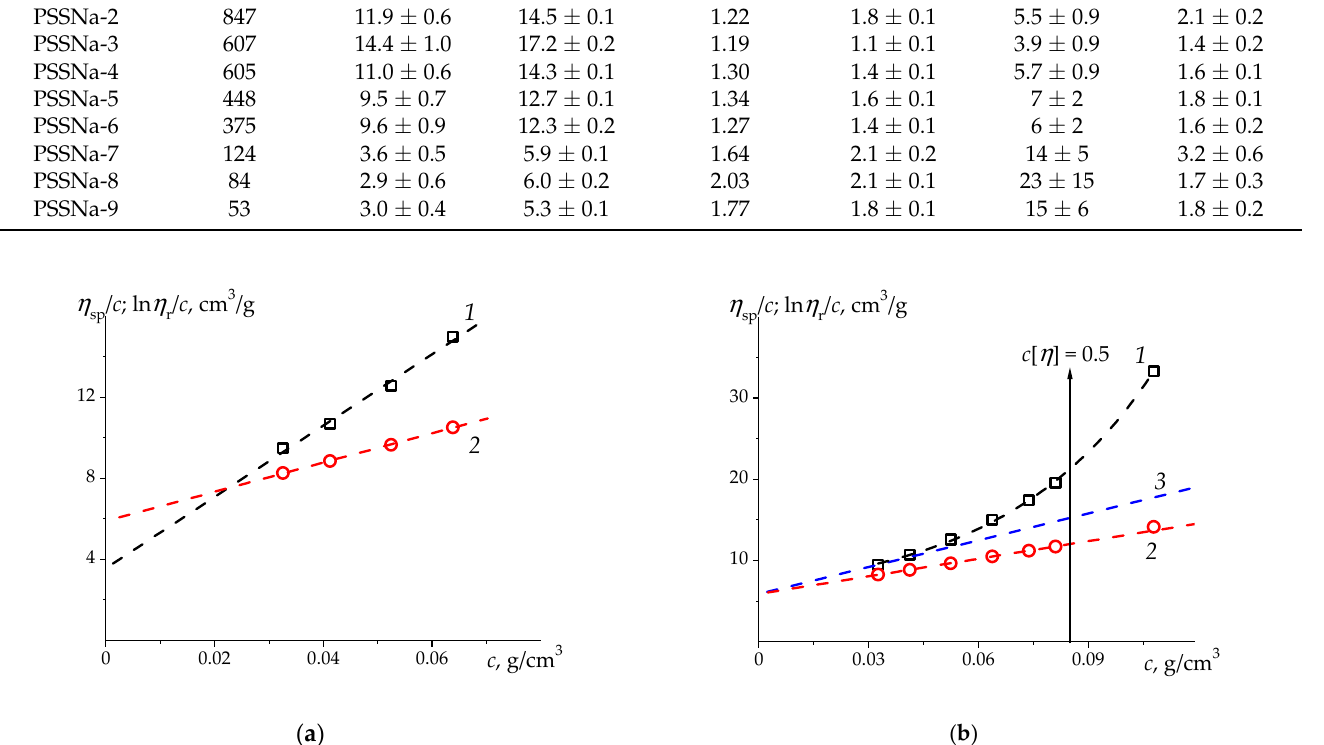
Figure 4. The Huggins (1) and Kraemer (2) plots for sodium polystyrene-4-sulfonate (PSSNa) (sample PSSNa-7 in Table 2) in aqueous 4.17 M NaCl ( θ -solvent at 25 °C) [54,59] with different data approximation: ( a )—linear fits (lines 1 and 2) in the range of relative